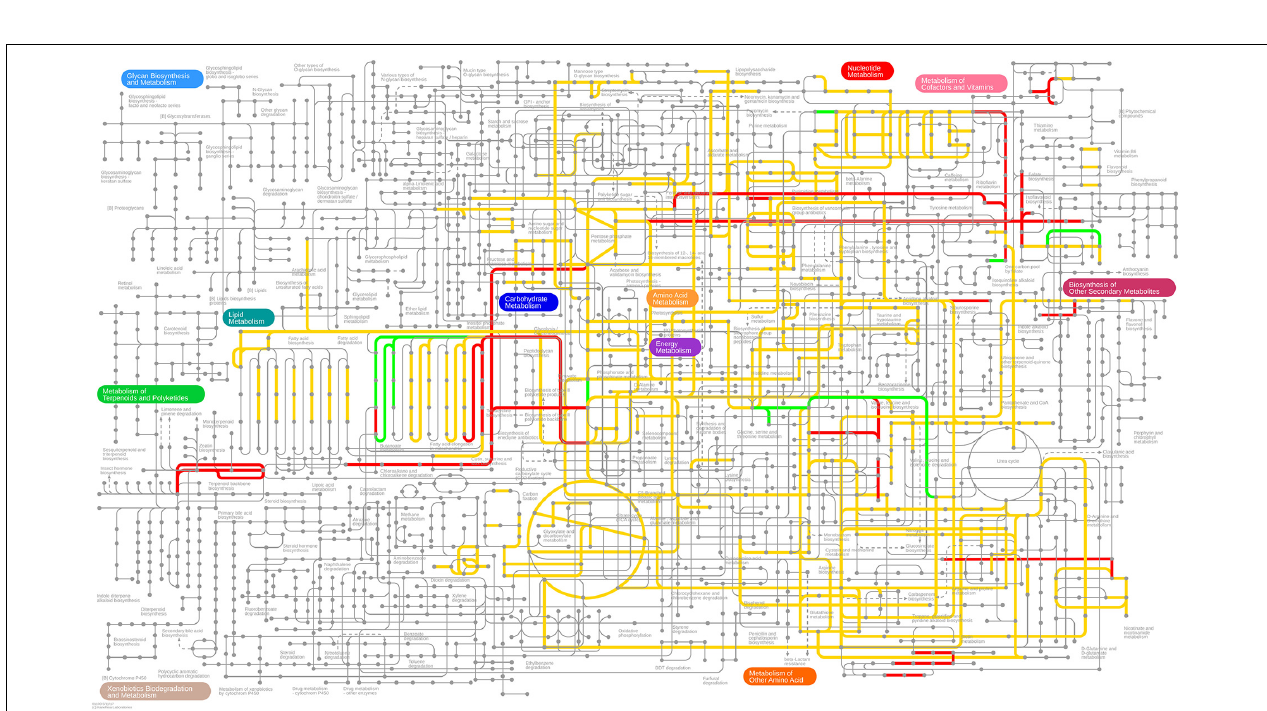
FIGURE 7 | Predicted up- and down-regulated median fluxes across ten biocides (Pereira et al., 2020) using the i ML1515 model, presented in the KEGG pathway map of E. coli . Up-regulated fluxes are green, down regulated fluxes red, and fluxes without a regulation requirement are colored yellow. No-flux reactions and reactions without KEGG IDs are omitted.